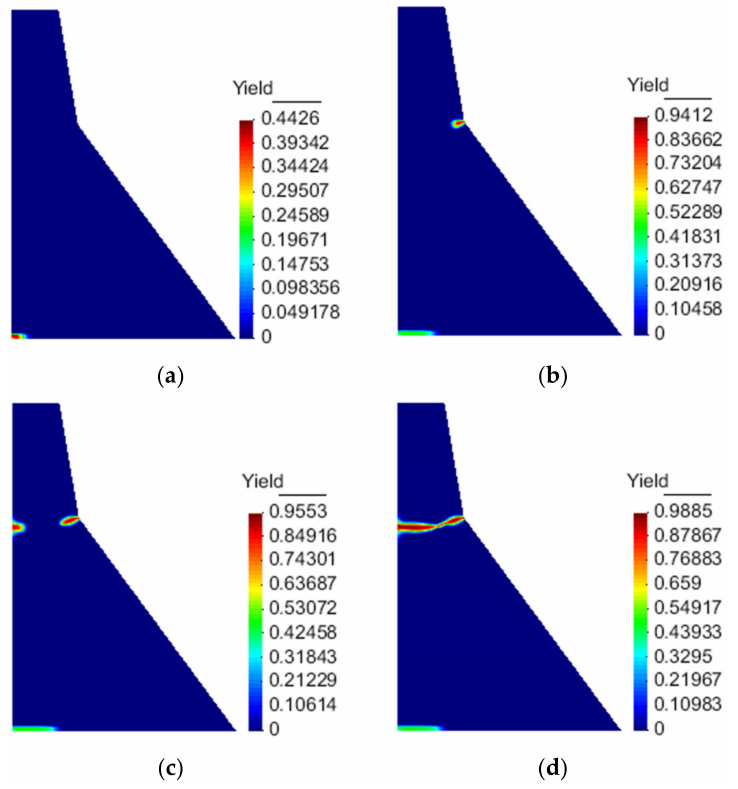
Figure 19. Damage distribution of the Koyna Dam at different times in the simulation results of the proposed model: ( a ) t = 2.7 s; ( b ) t = 4.0 s; ( c ) t = 4.26 s; ( d ) t = 4.5